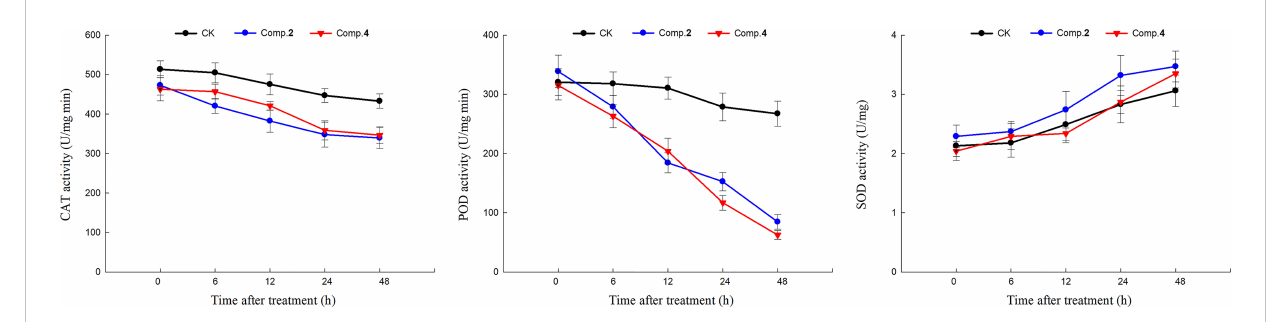
FIGURE 6 The effects of compounds 2 and 4 (100 m g/mL) on antioxidant-related enzymes (CAT, POD, SOD) activities of A. thaliana .